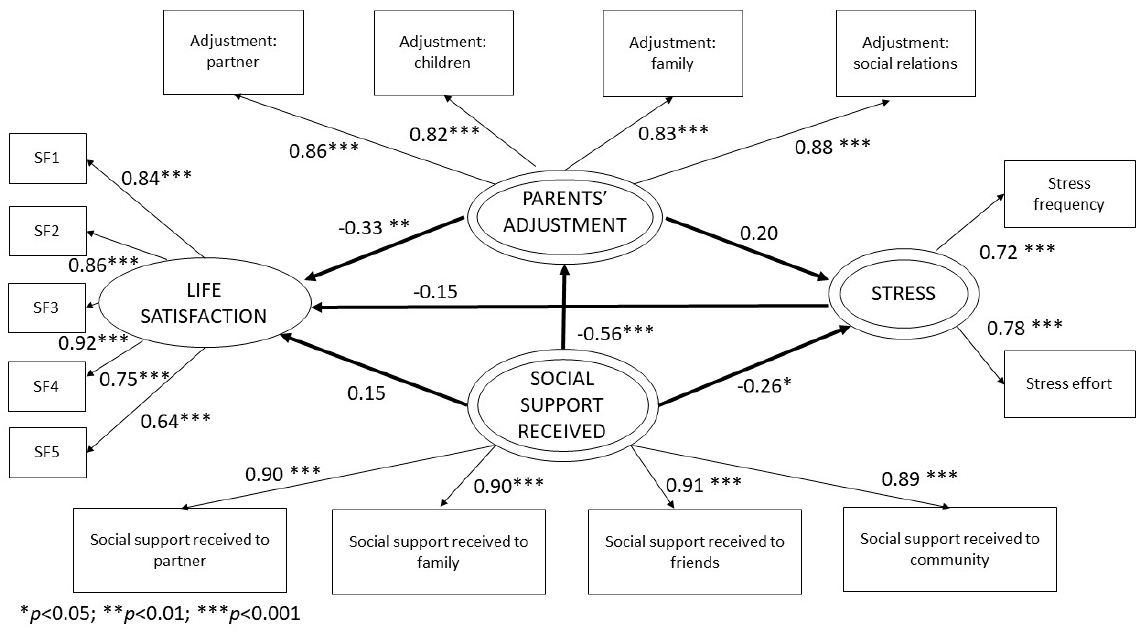
Figure 3. Structural social support received model results.